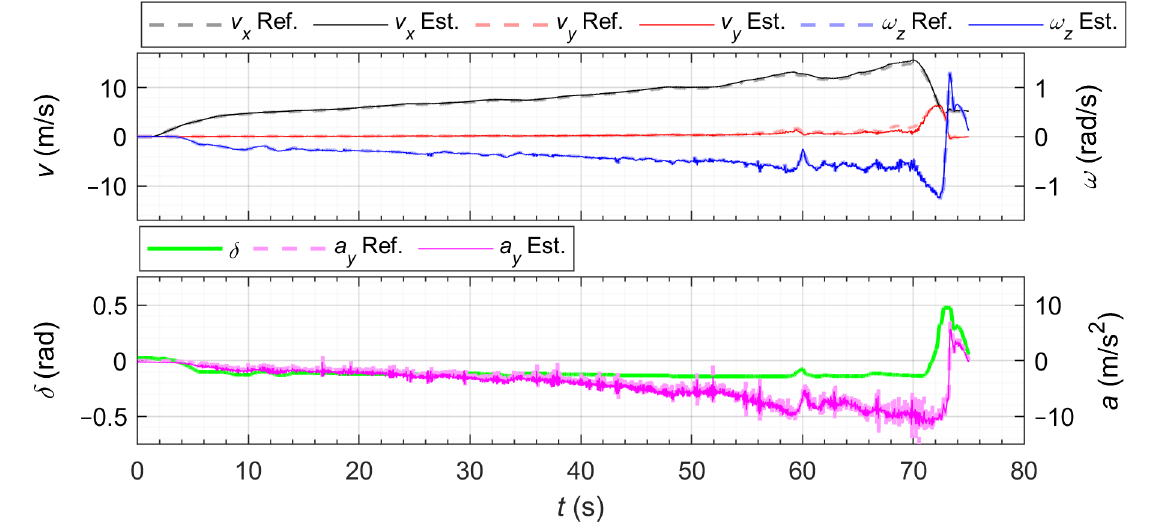
Figure 7. Test data—circular steady-state driving maneuver on dry road surface: measured and estimated velocities, yaw rate, lateral acceleration, and steering